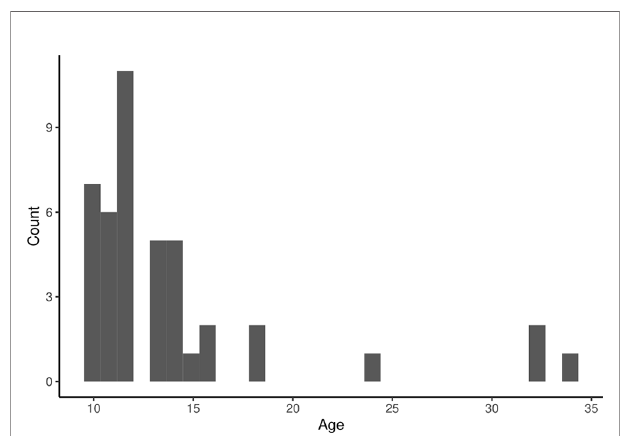
FIGURE 2 | Histogram showing the age frequencies of known-age, sexually mature females that have never been observed with a calf and were presumed alive as